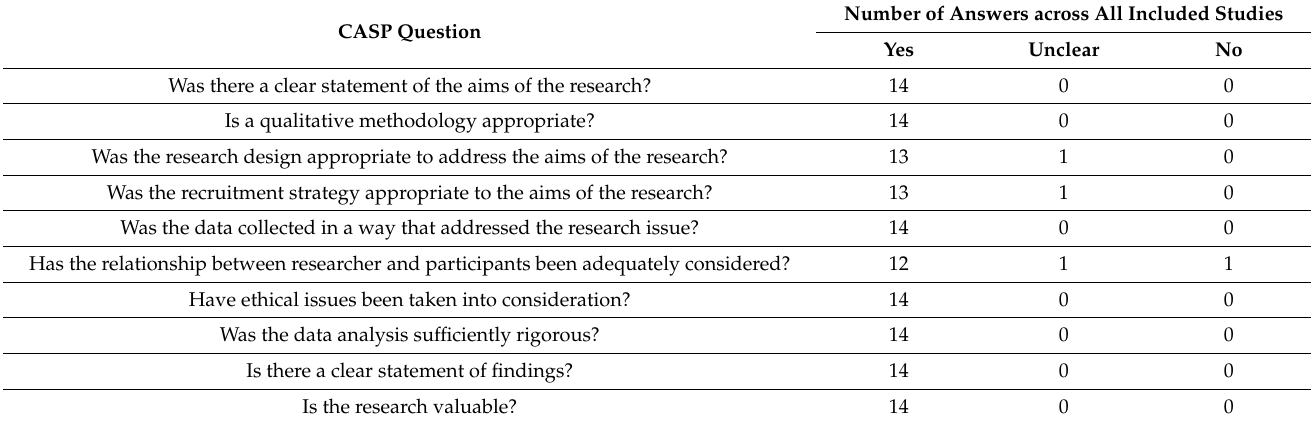
Table 2. Summary of the Critical Appraisal Skills Programme (CASP) judgments.